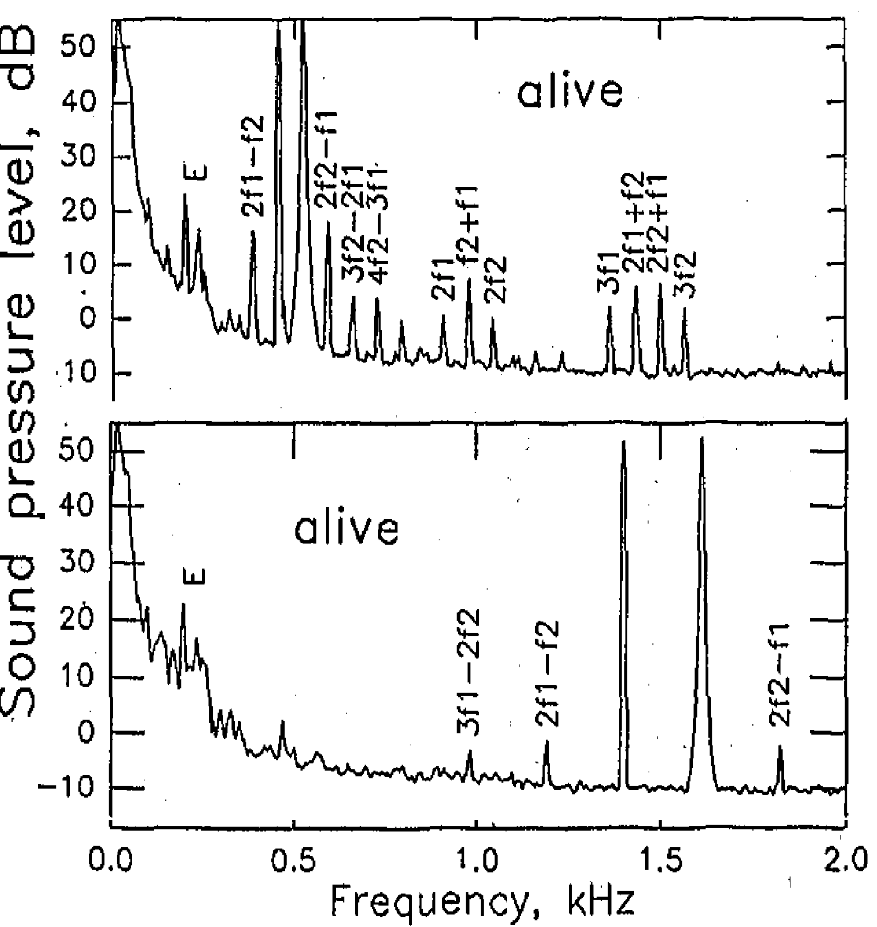
Figure 2. DPOAE spectra produced by two-tone stimulation in the skink Tiliqua rugosa . Top panel: low-frequency stimulation with f 1 and f 2 near 0.5 kHz. Lower panel: higher-frequency stimulation, with f 1 and f 2 near 1.5 kHz. E, electrical noise. Partially after [41].